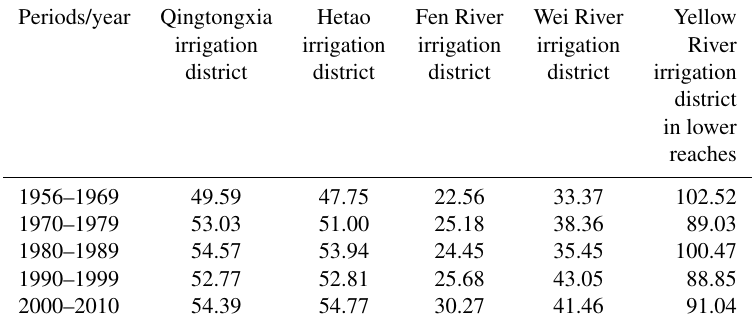
Table 4. Irrigation requirement of main irrigation districts of Yellow River in different periods (unit: 0.1billionm 3 .